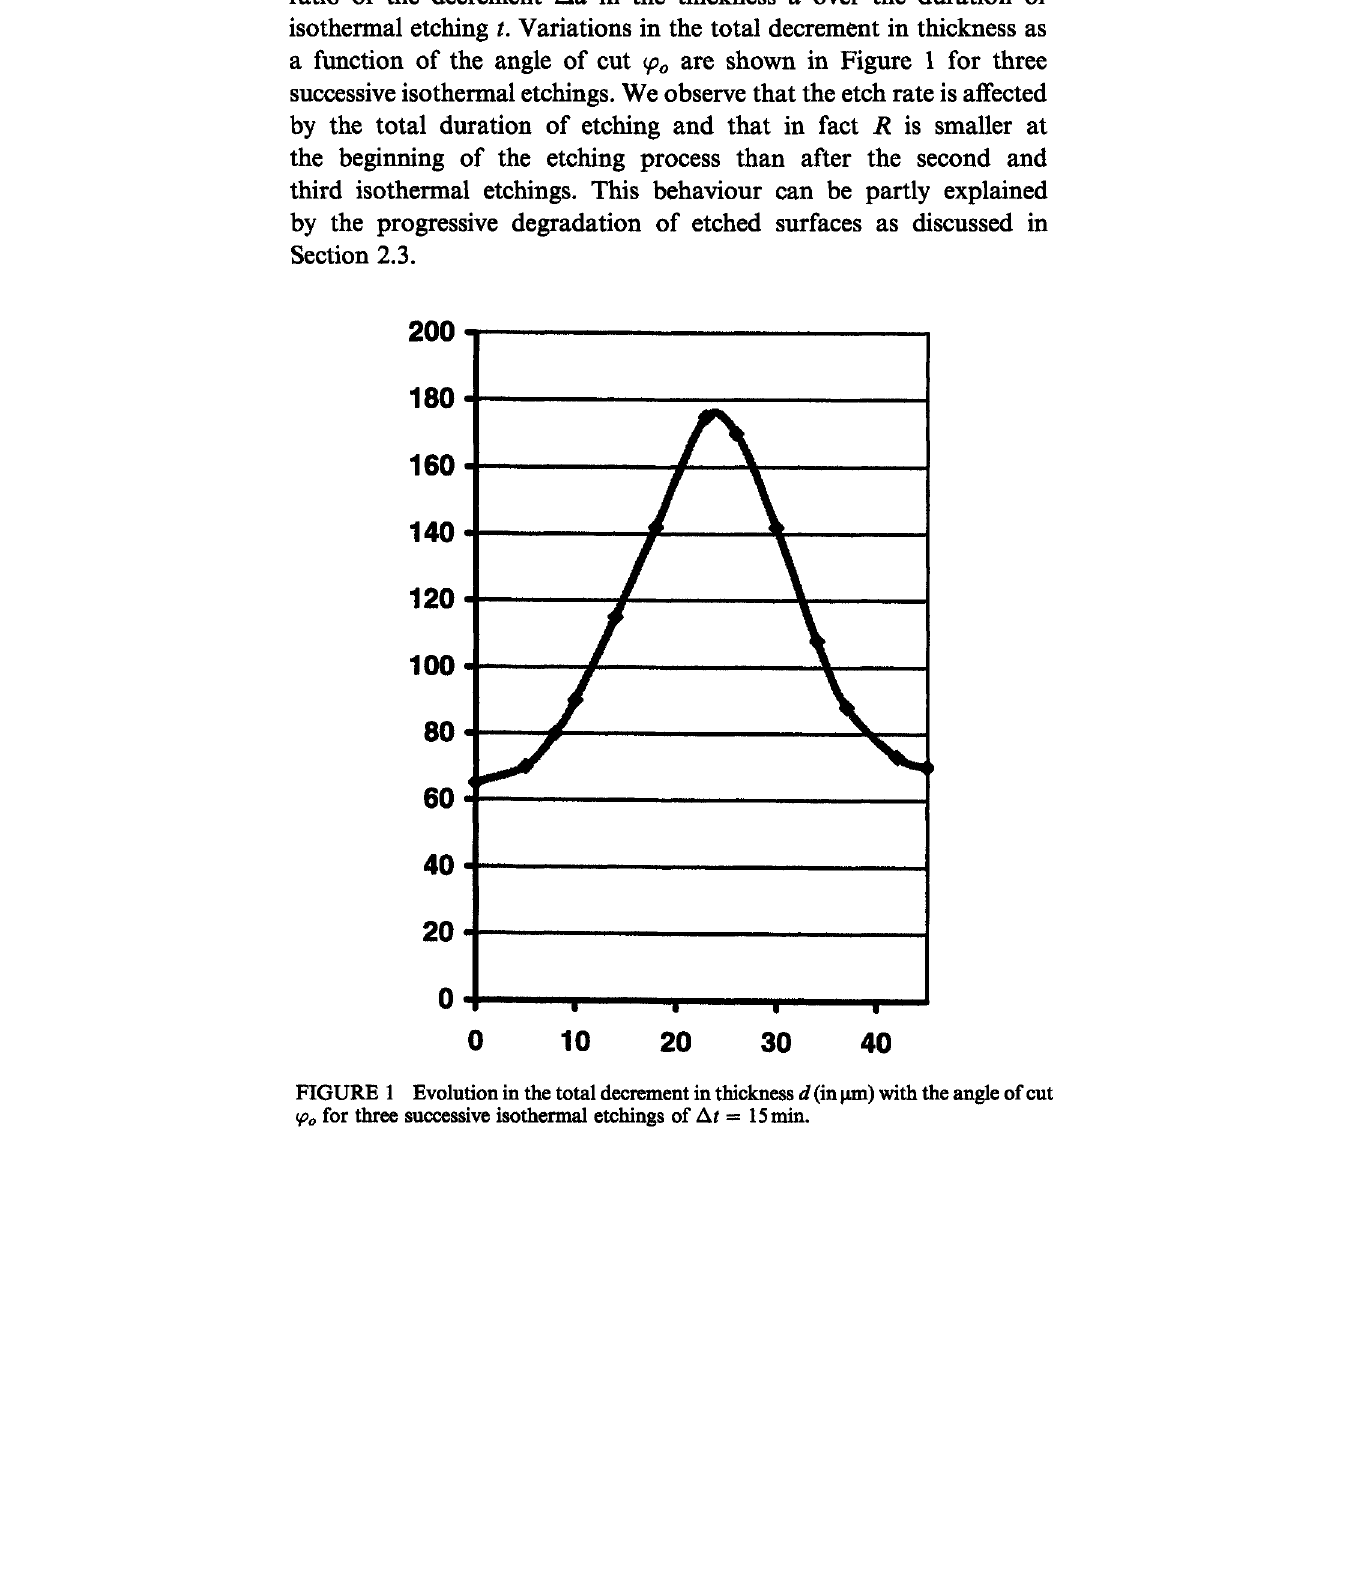
FIGURE Evolution in the total decrement in thickness d (in tm) with the angle of cut qao for three successive isothermal etchings of At 15